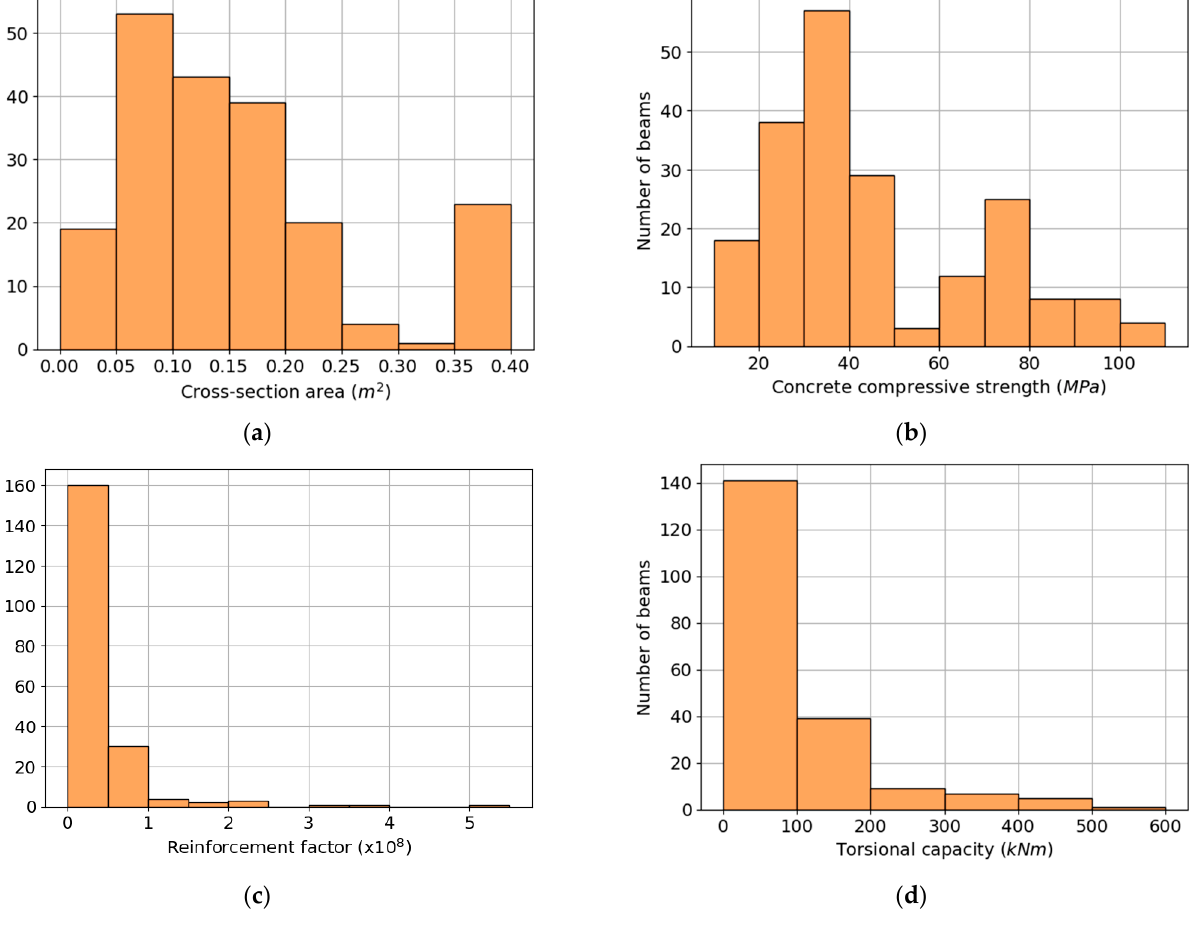
Figure 3. Histograms of input and output variables: ( a ) cross-section area, ( b ) concrete compressive strength, ( c ) reinforcement factor, and ( d ) torsional capacity.